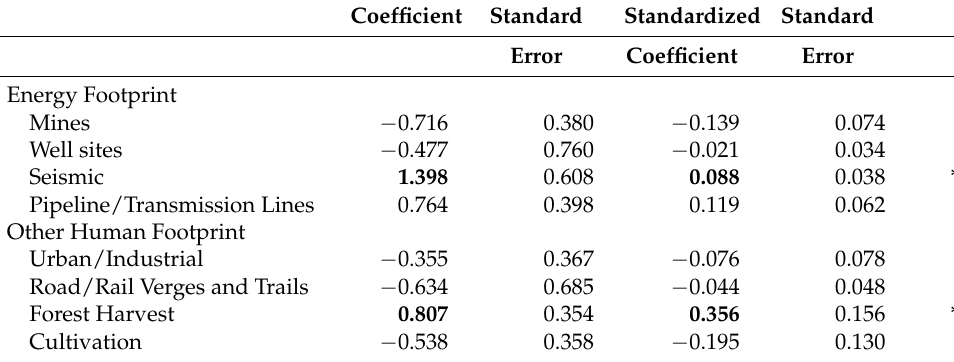
Table A4. Summaries of multiple regression model of Shannon’s diversity for oribatid mites in the oil sands region of Alberta,